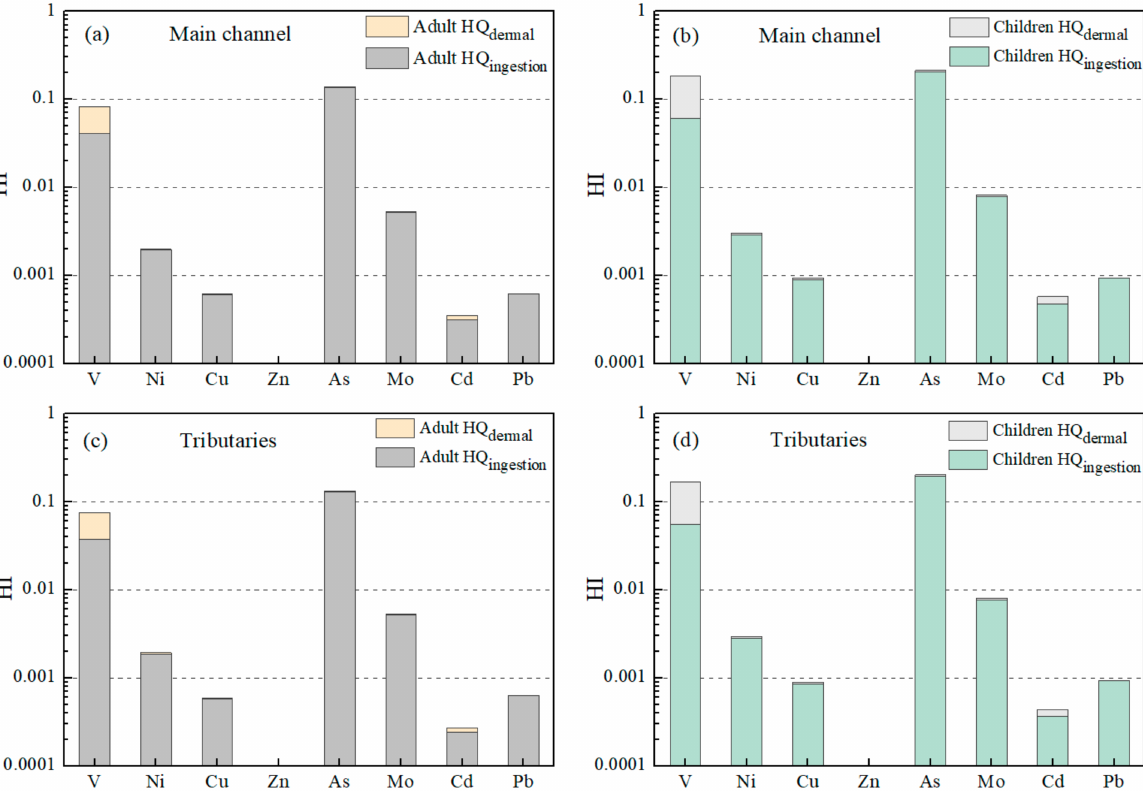
Figure 6. The HQ and HI values of HMs in the main channel and tributaries of the upper TGR area for adults and children, ( a ) HI values for adult in main channel, ( b ) HI values for children in main channel, ( c ) HI values for adult in tributaries, ( d ) HI values for children in